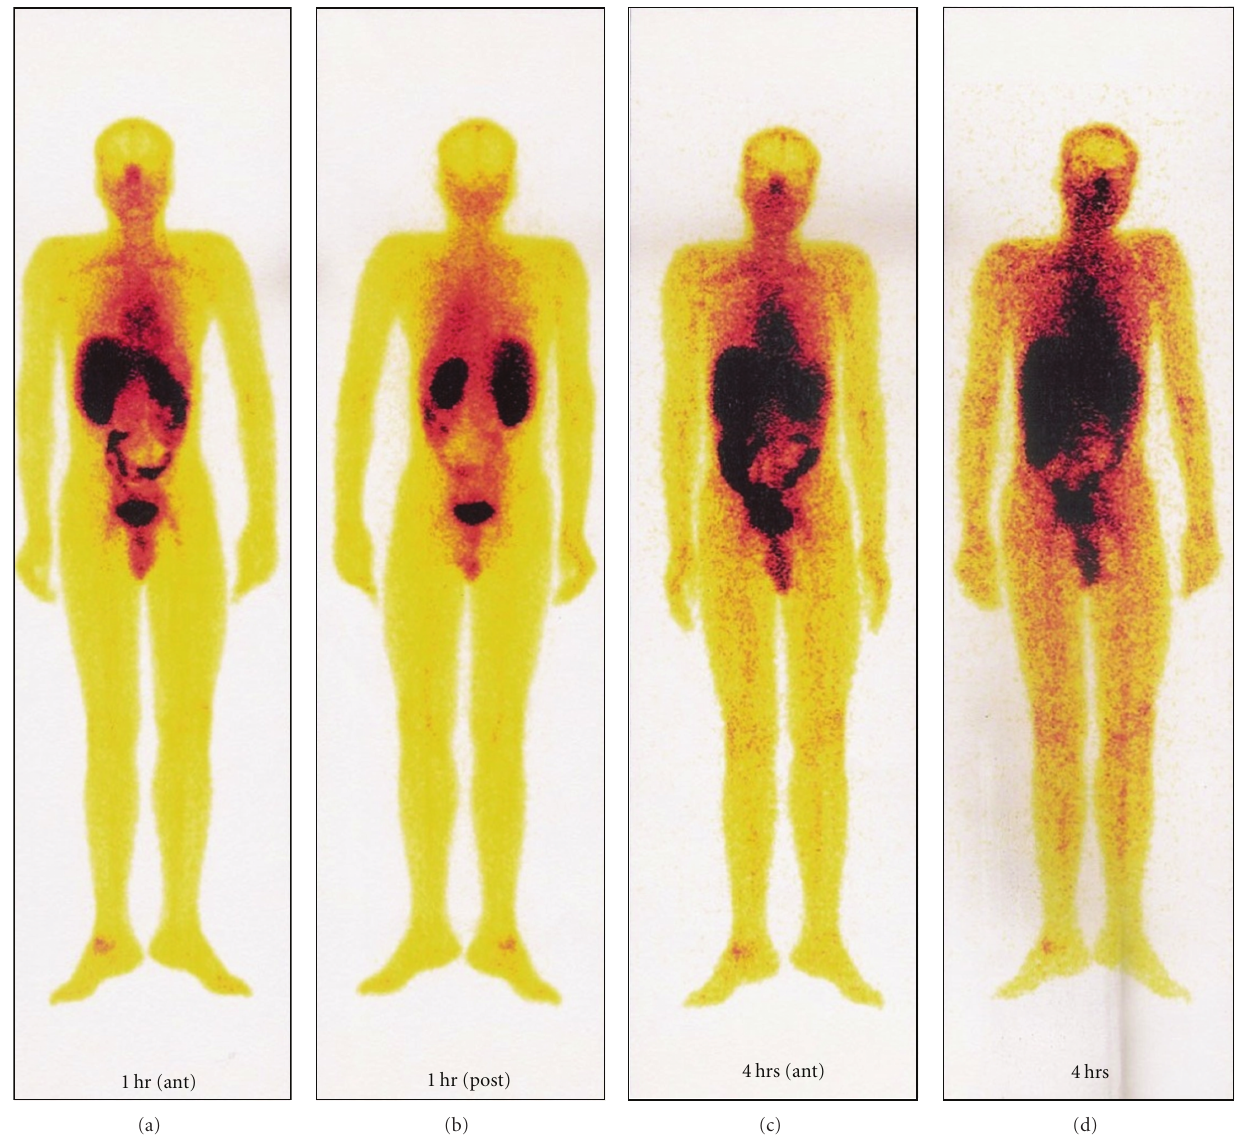
Figure 2: Whole body scan of human (healthy volunteer) showing biodistribution of 99m Tc-EMB in human at 1 hour anterior and posterior and 4 hours anterior and posterior (postinjection of radiotracer and lesion in ankle (Bone TB).